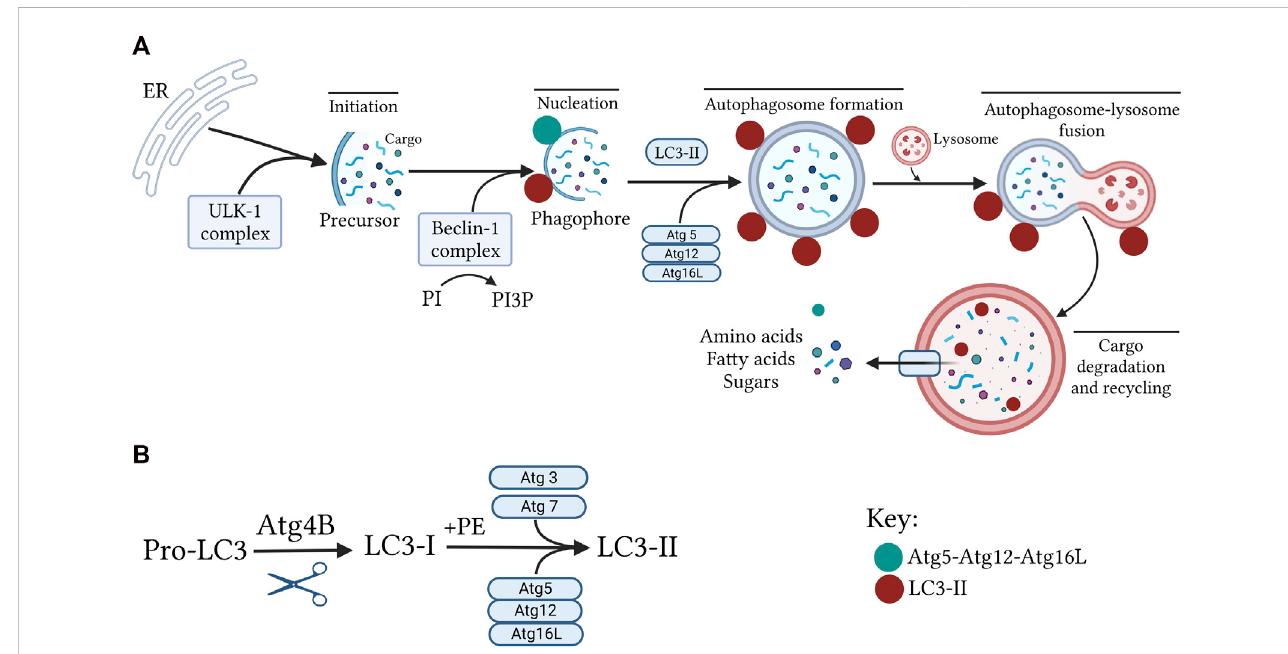
FIGURE 4 Molecularmechanismoftheautophagypathway. (A) theschemedepictsthesequentialstepsinvolvedintheautophagyprocess.Thisprocessstartswith the formation of isolation membrane by the Unc51-like kinase 1 (ULK1) complex primarily at the endoplasmic reticulum (ER) followed by nucleation of this membrane to produce the cup-shaped phagophore. Subsequently, the Atg5 – Atg12-Atg16L complex along with processed light chain-II (LC3-II) extended thisphagophoretoencaseautophagiccargoinadouble-membranedautophagosome.Theloadedautophagosomethenmergeswiththelysosomefor breaking down of infused cargo and recycling. Notably, the Atg5 – Atg12-Atg16L complex is dissociated from the autophagosomal membrane while LC3-II continues to attach to the mature autophagosomes until vesicle degradation, making it a speci fi c and reliable autophagosomal marker. (B) LC3 processing. Upon activation of autophagy, pro-LC3 is fi rst cleaved by Atg4B to produce LC3-I. This is followed by lipidation of LC3-I with phosphatidylethanolamine (PE) to generate LC3-II with the help of Atg7 and Atg3 as well as the Atg5-Atg12-Atg16L